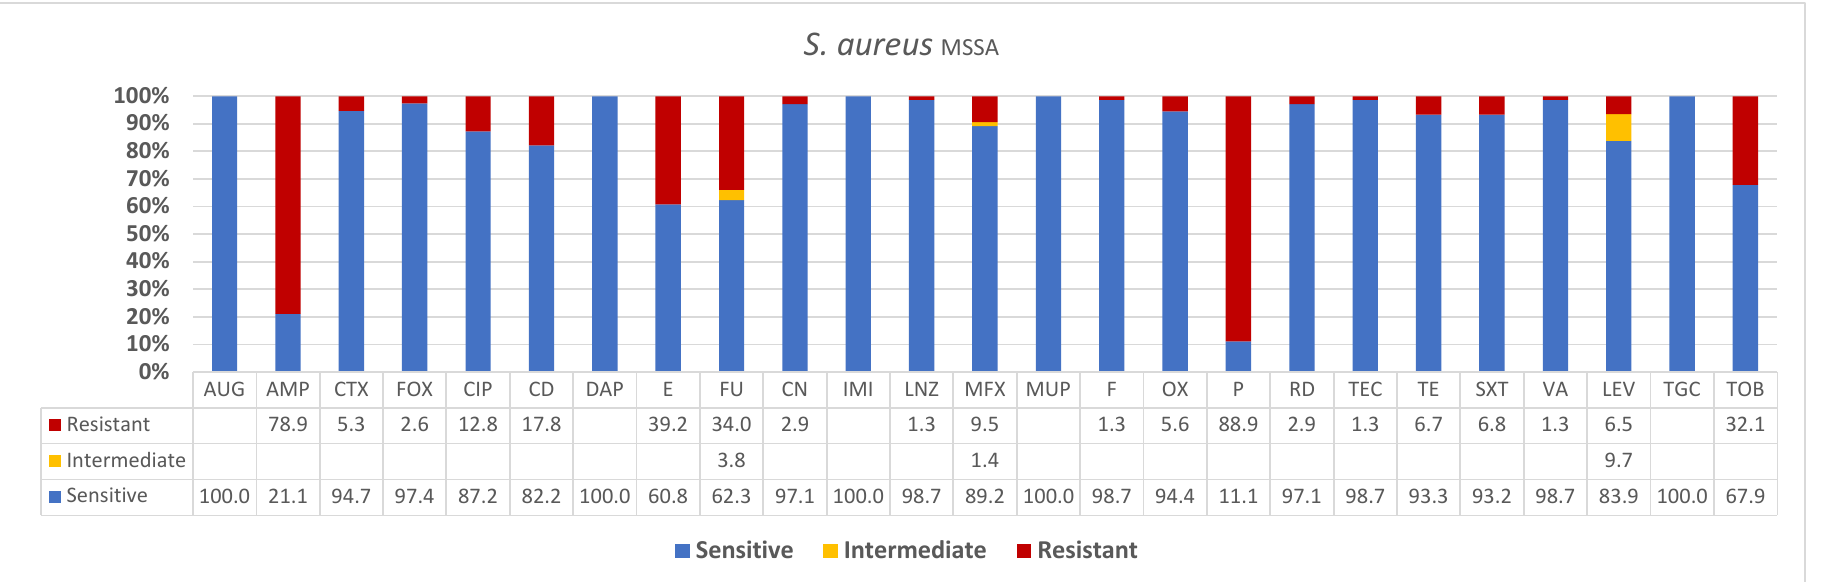
Figure 2. Antibiogram patterns of methicillin-susceptible Staphylococcus aureus isolates recovered from clinical specimens in Ha’il region, Saudi Arabia